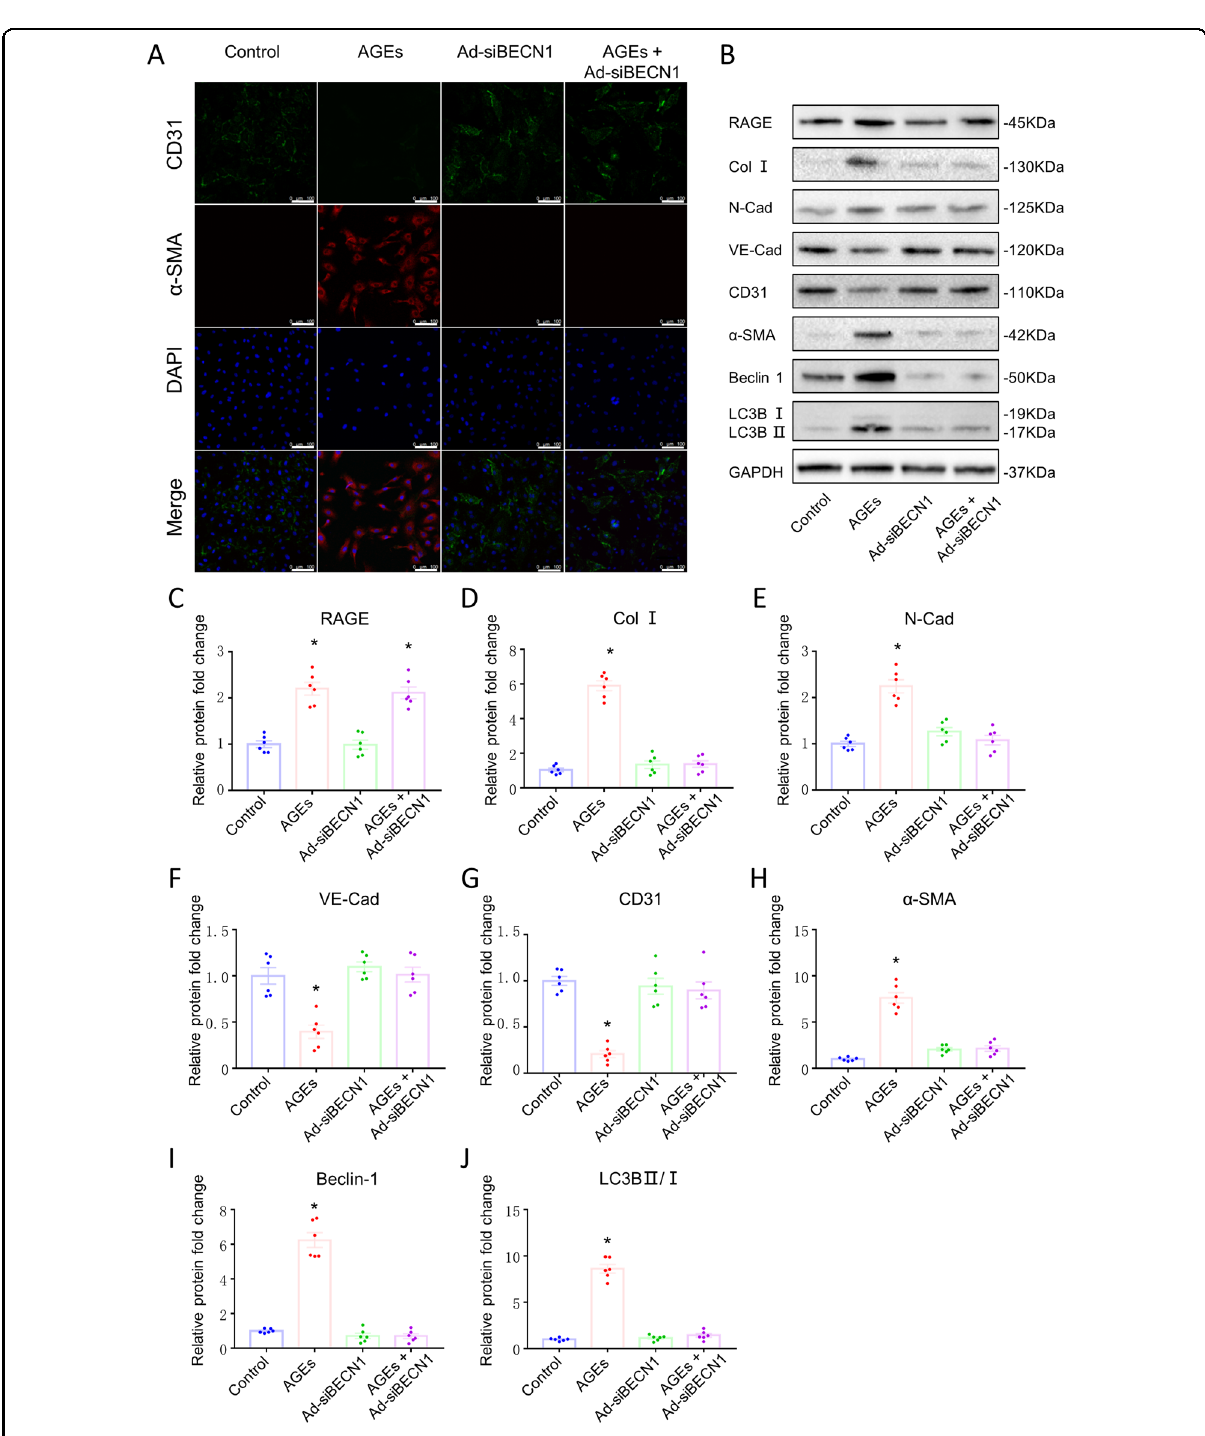
Fig. 6 AGEs-RAGE induced EndMT by mediating endothelial autophagy in HUVECs. A Confocal microscopic image of double immuno fl uorescence staining for CD31 (green) and α -SMA (red); nuclei were counter stained with DAPI (blue); (Scale bars = 100 µm). B Protein expression of Beclin 1, LC3BII/I, RAGE, Collagen I, N-Cadherin, VE-Cadherin, CD31, and α -SMA assessed by western blotting. Quanti fi cation of RAGE ( C ), COL I ( D ), N-Cadherin ( E ), VE-Cadherin ( F ), CD31 ( G ), α -SMA ( H ), Beclin 1 ( I ), and LC3BII/I ( J ). GAPDH was used as the internal control. n = 6. Data are presented as mean ± SEM. * p < 0.05 vs. control